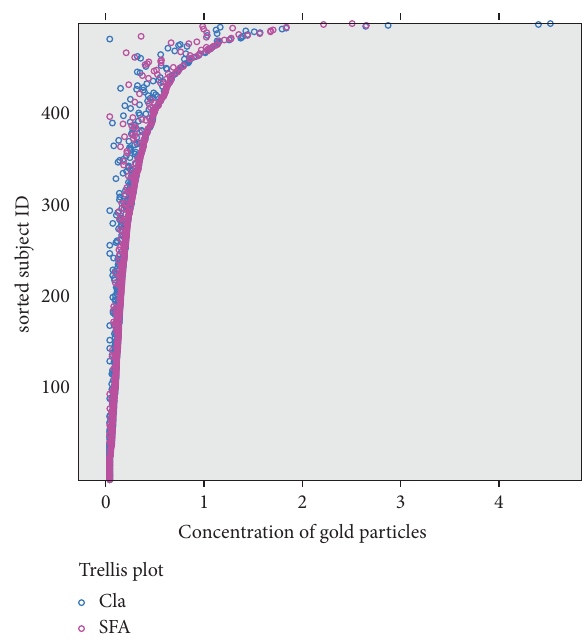
Figure 2: Trellis plot for gold particle data.